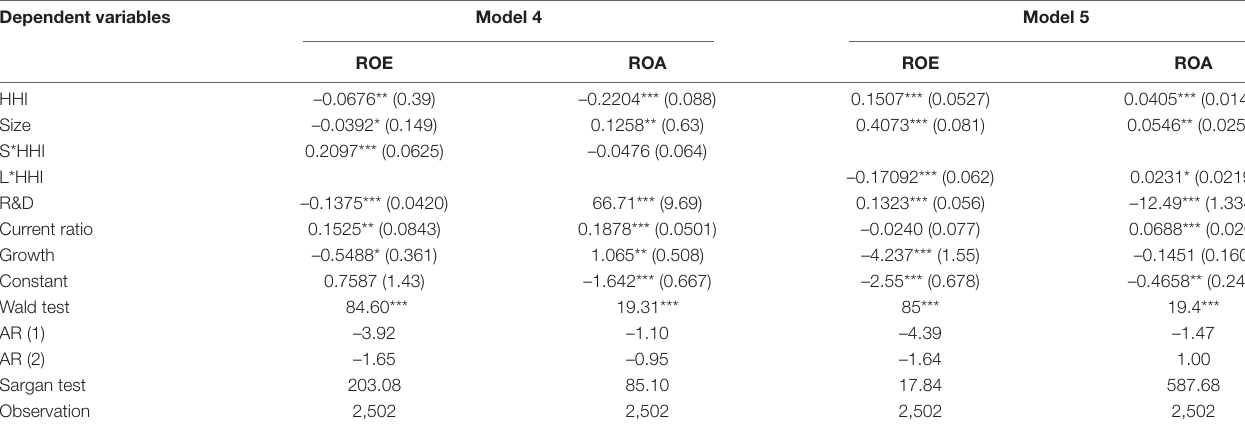
TABLE 3 | Market competition and firm performance: a moderating effect of firm